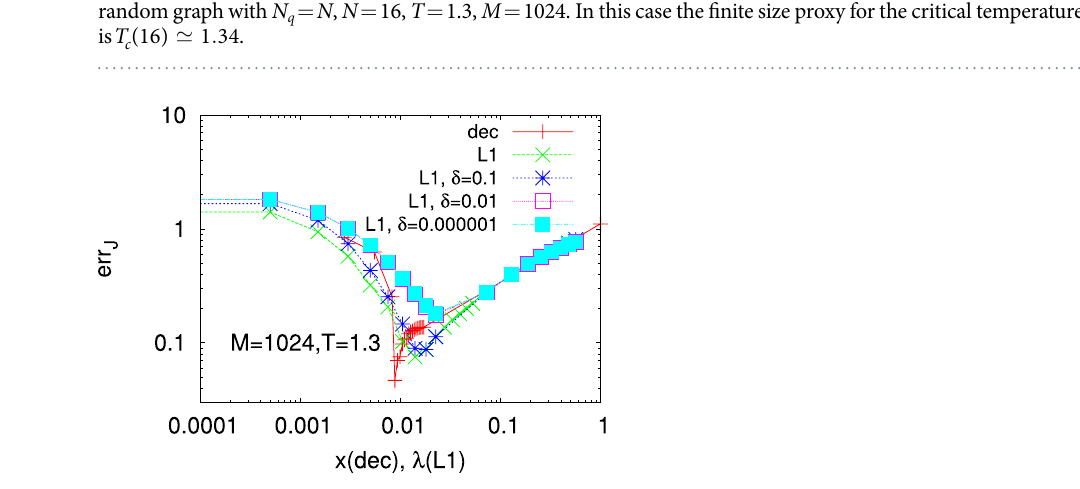
Figure 2. Reconstruction error for the 4 XY model on sparse Erdos-Renyi graph with N q = N = 16, M = 1024 at T = 1.3. The error obtained following various  -regularized PLMs is displayed vs. λ ; the decimation PLM 1 reconstruction error is plotted against the fraction of non-decimated couplings x